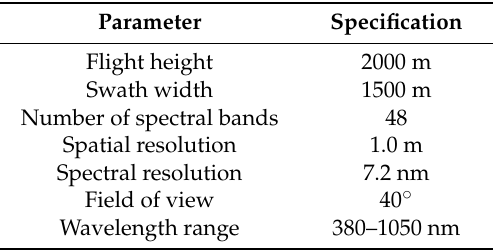
Table 1. Specification of the CASI dataset